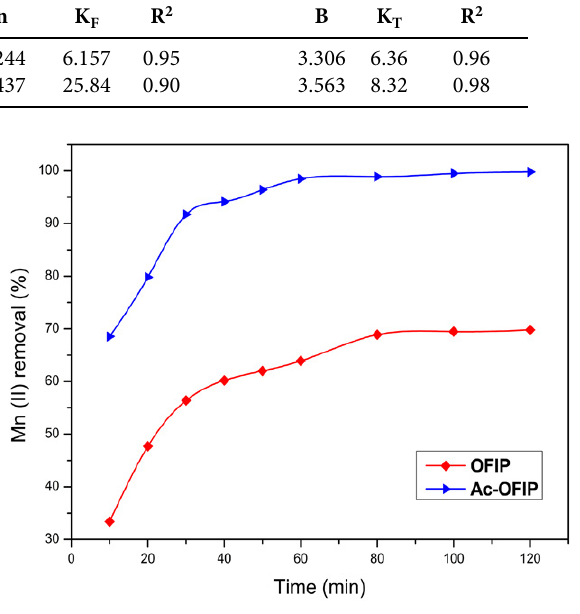
Fig. 7. Effect of contact on removal rate for OFIP and Ac-OFIP.